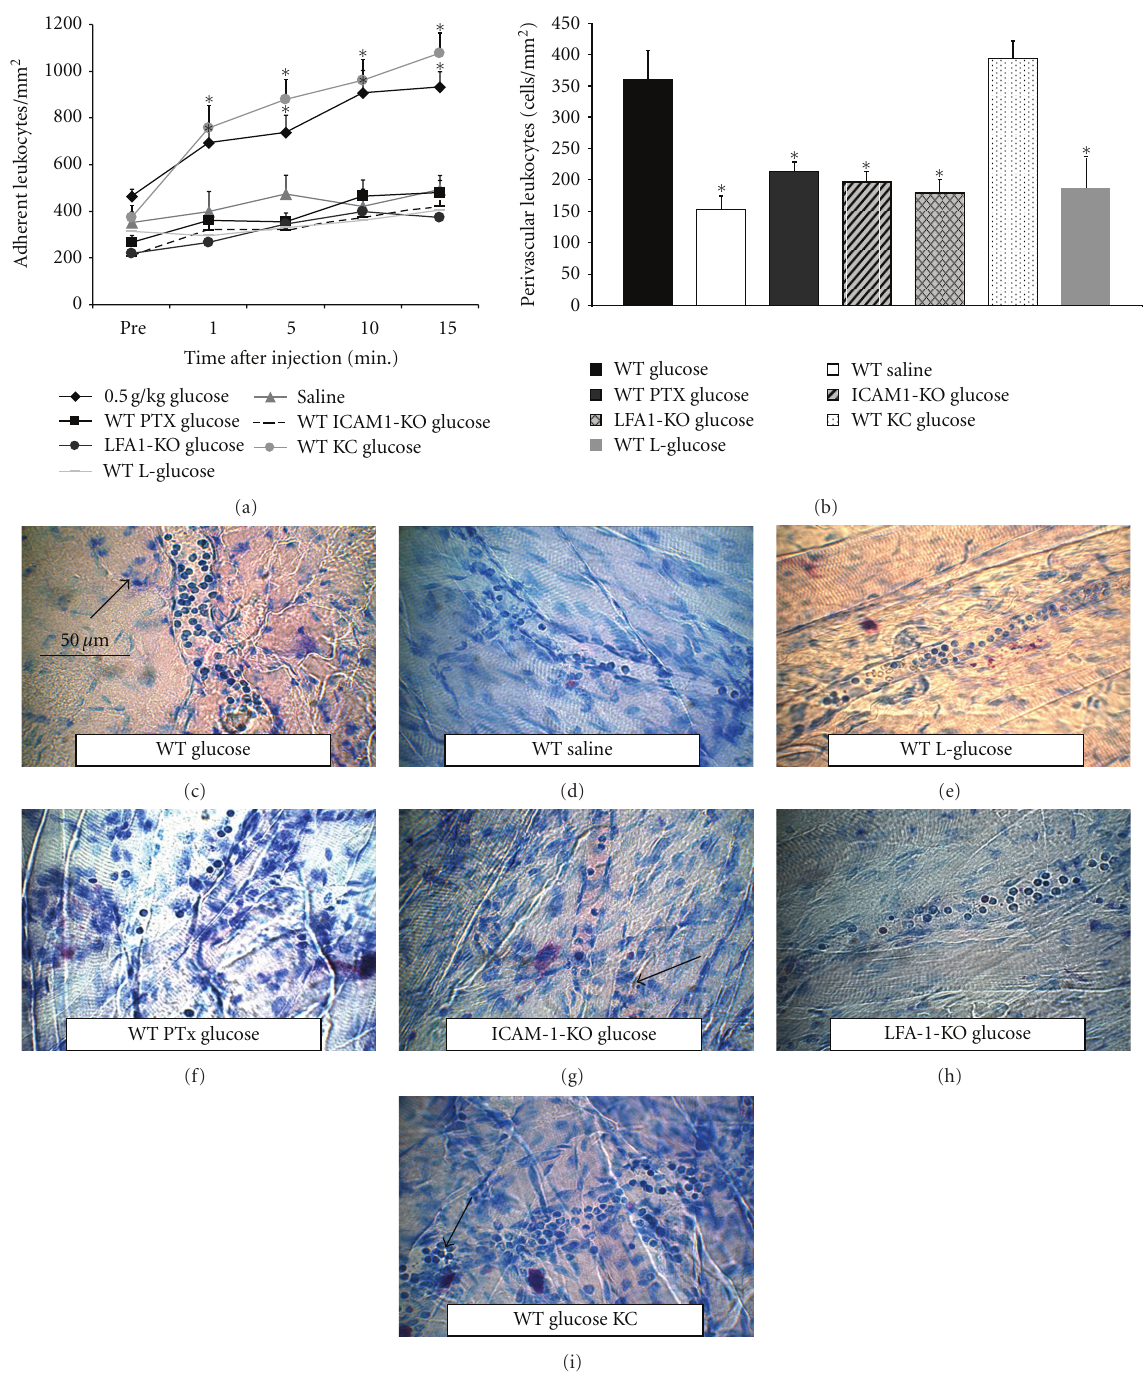
Figure 1: Leukocyte adhesion (number of adherent cells/mm 2 ) in mouse cremaster muscle venules and leukocyte transmigration (perivascular neutrophils/mm 2 surface area) in cremaster muscle whole mounts in response to glucose during trauma-induced inflammation. (a) Leukocyte adhesion was observed in trauma-stimulated cremaster muscle venules of wild-type mice (64 venules in 16 mice), LFA1-KO mice (19–25 venules in 4 mice), and ICAM1-KO mice (18–22 venules in 4 mice) before and during 15 minutes after intravenous injection of 0.5g/kg glucose. To dissect the role of the chemokine pathway in this model, WT mice were either pretreated with 4 μ g PTx 3h prior to cremaster exteriorization and glucose stimulation or coinjected with 600 ng CXCL1 (KC) and glucose and compared to injection of normal saline. WT mice injected with the equivalent volume of normal saline (18 venules in 4 mice) and the biologically inactive L-glucose (13–28 venules in 5 mice) served as controls. (b) Giemsa-stained cremaster muscle whole mounts of WT mice were analyzed for the number of perivascular neutrophils (per mm 2 surface area) after injection of glucose or normal saline in the trauma model). In parallel, leukocyte extravasation was quantified in glucose-treated LFA1-KO, ICAM1-KO mice, and WT mice pretreated with 4 μ g PTx 3h prior to cremaster muscle exteriorization or coinjected with 600ng CXCL1. To further illustrate the results representative micrographs of cremaster muscle whole mounts are shown in (c)–(i). Reference bar is shown in (c). Arrows point to extravasated leukocytes. All values are presented as mean ± SEM. Significances are indicated by the asterisks ( ∗ P < 0 . 05 versus WT control